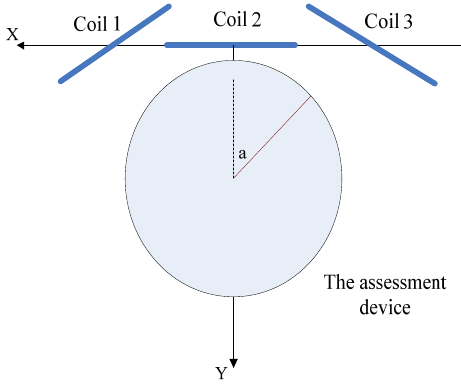
Figure 9. The first layout style of the experimental equipment (top